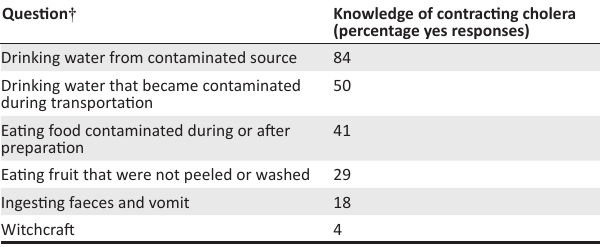
TABLE 3: Respondents’ knowledge on contracting cholera.